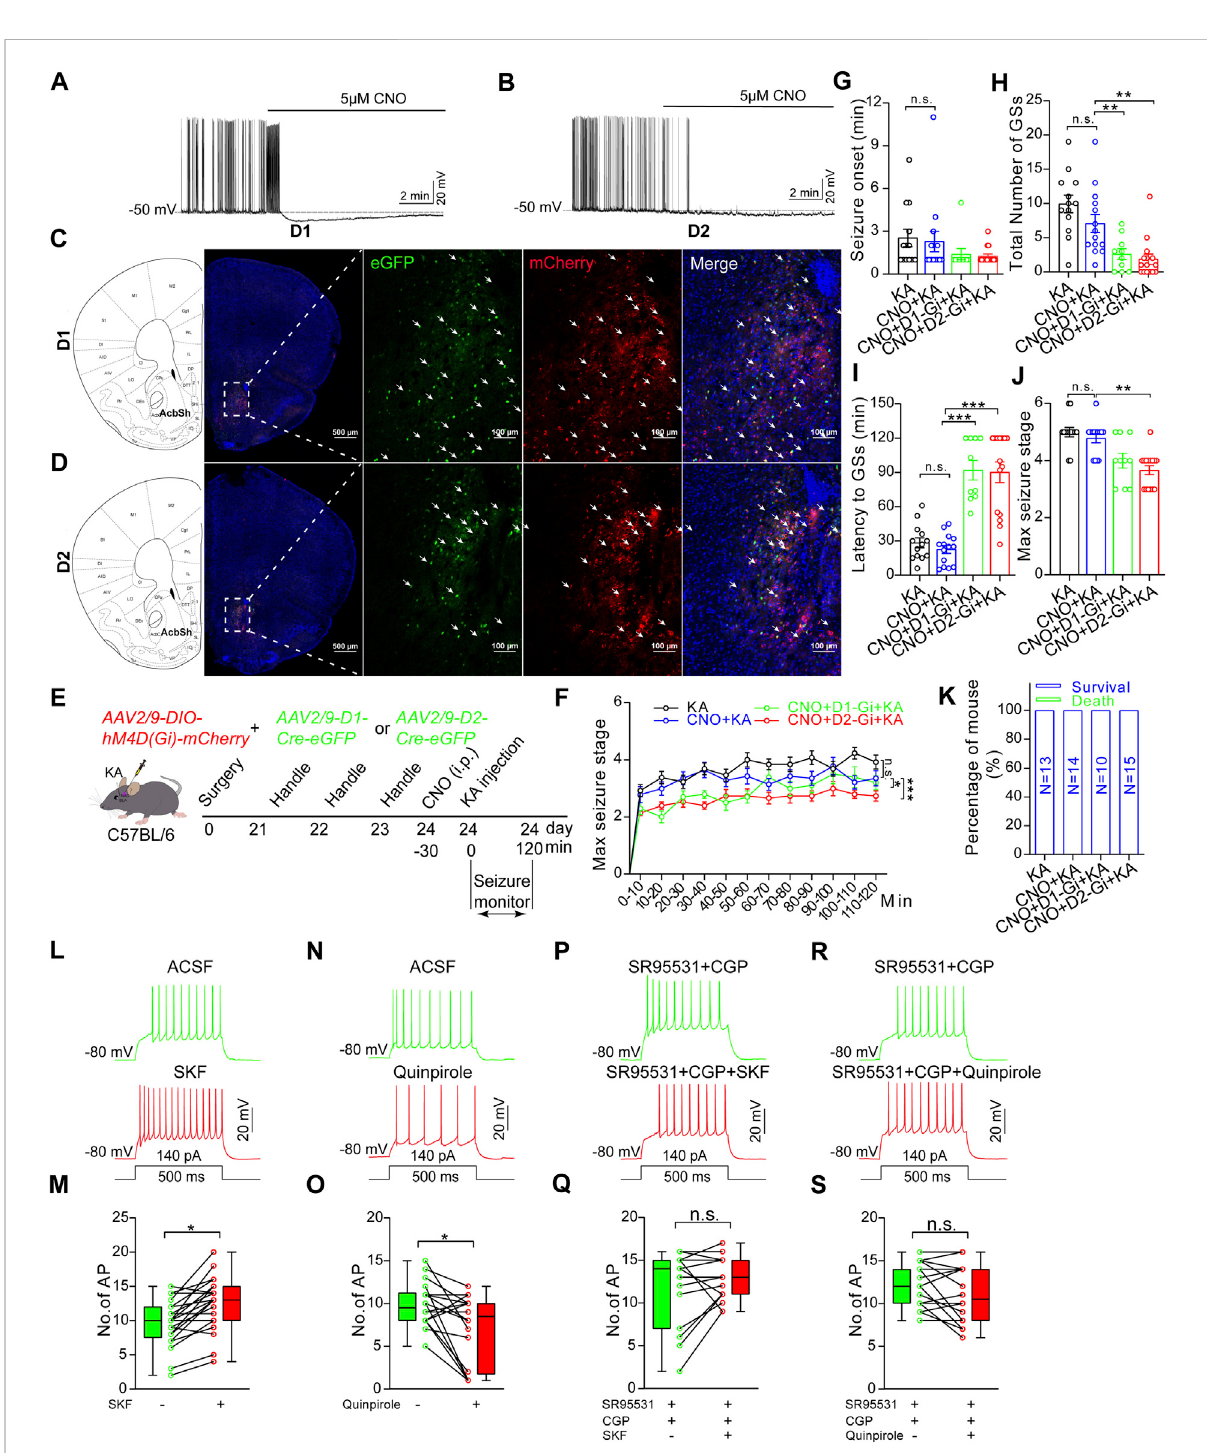
ChemogeneticinhibitionofD1R-MSNorD2R-MSNintheNAcshellalleviatesTLEseizures. (A) RepresentativerecordingshowsspontaneousAP fi rings of D1R-MSN and (B) D2R-MSN transfected with DREADD receptor hM4D (Gi) are suppressed by CNO (5 μ M) perfusion. Membrane potential was held under current-clamp at around − 50 mV. (C) Representative confocal images show the expression of mCherry and eGFP on D1R-MSN transfectedwithAAV2/9-DIO-hM4D(Gi)-mCherryandAAV2/9-D1-Cre-eGFPviruses. (D) Representativeconfocalimagesshowtheexpression ofmCherryand eGFPon D2R-MSN transfectedwith AAV2/9-DIO-hM4D(Gi)-mCherry and AAV2/9-D2-Cre-eGFP viruses. (E) Schematicdiagram of experimental design to examine the effects of chemogenetic inhibition of D1R-MSN or D2R-MSN in the NAc shell on TLE seizures induced by